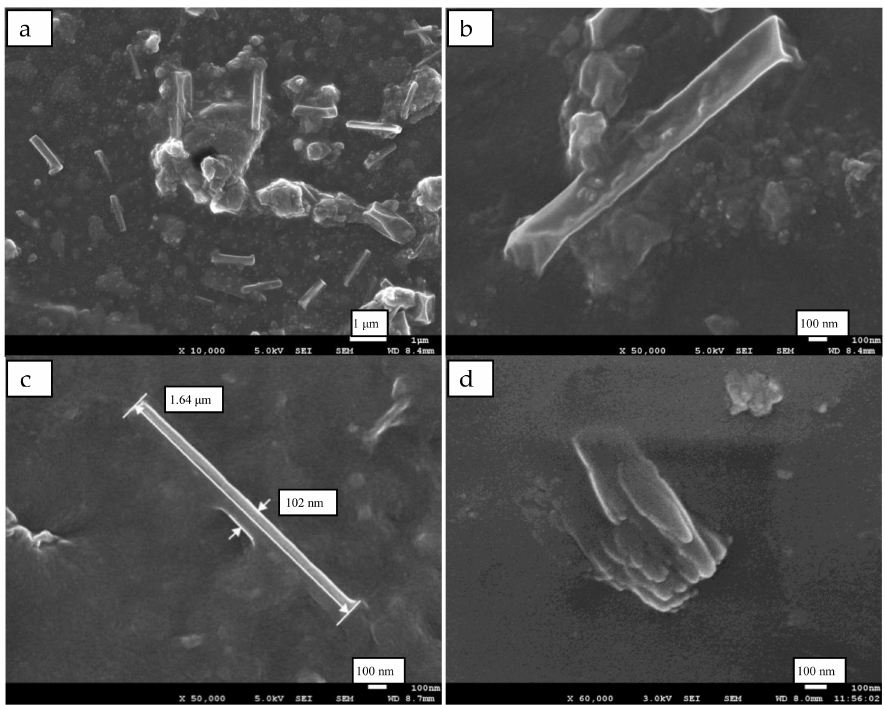
Figure 3. SEM images ( a ) of the tensile fracture of RRC/NR composites. ( b , c ) are the amplification of ( a ); ( d ) is the unseparated RRC.